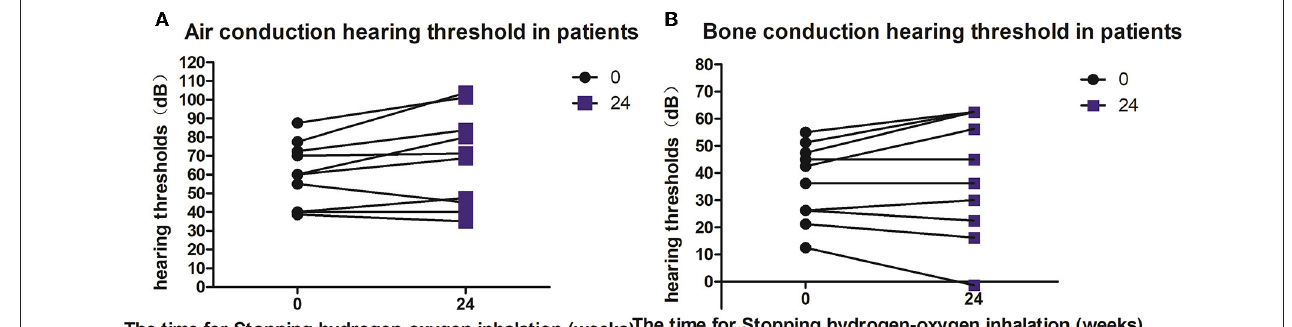
FIGURE 4 | Hearing changes in patients after hydrogen and oxygen inhalation therapy was discontinued. (A) Diagram of changes in air conduction hearing threshold after stopping hydrogen-oxygen inhalation therapy for 24 weeks; (B) Figure of changes in bone conduction hearing threshold after stopping hydrogen-oxygen inhalation therapy for 24 weeks. Paired t test was used for data